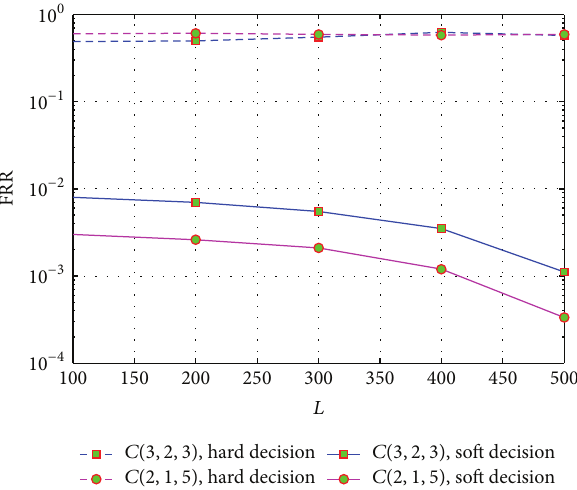
Figure 5: Recognition performances of GJETP method. Figure 6: Recognition performances on different size of R 𝑙 for soft and hard decisions.